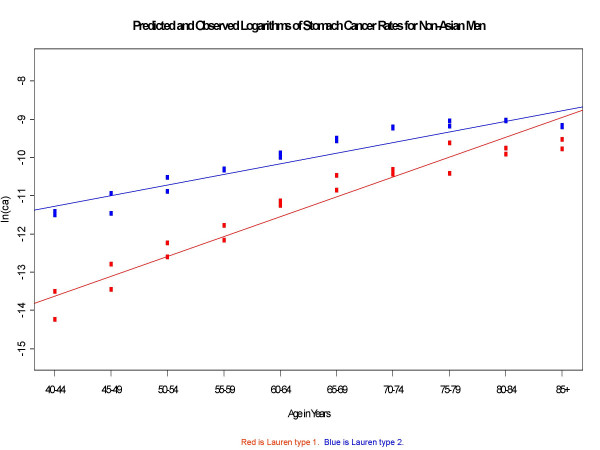
Plot of the natural logarithms of cancer rates, denoted as ln(ca), as a function of age in years for non-Asian men. Red references Lauren type 1 gastric cancer. Blue references Lauren type 2 gastric cancer. Lines represent predicted values. [see Additional file 1]